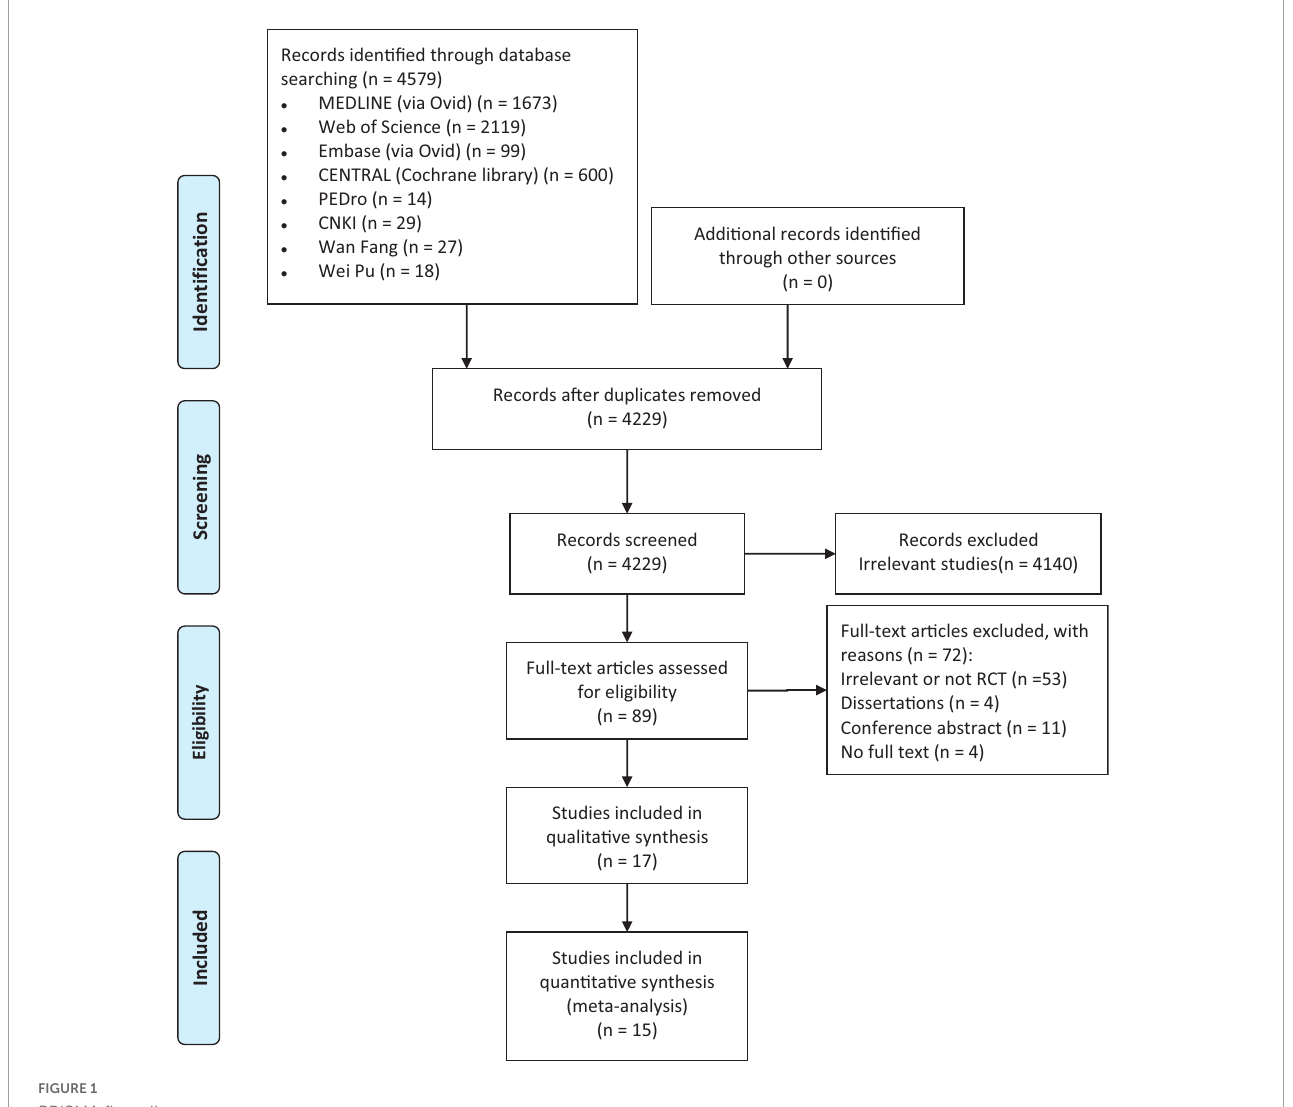
FIGURE1 PRISMA flow